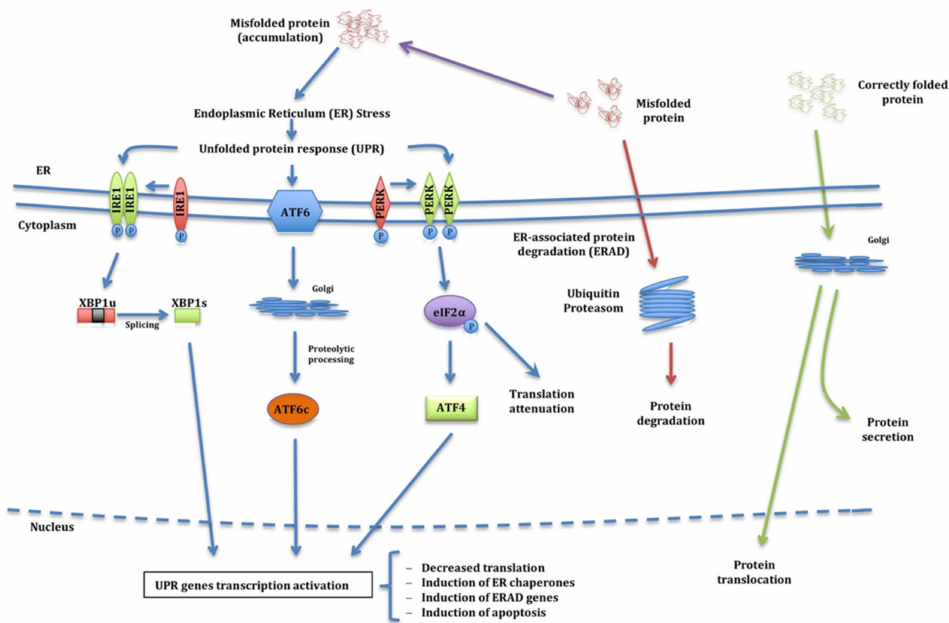
Figure 2. Signalling pathways of the Unfolded Protein Response (UPR). In a normal situation inside the endoplasmic reticulum, proteins are folded and taken to the places where they carry out their function (green arrows). When proteins are not folded correctly, they are stored in the lumen of the endoplasmic reticulum (ER), and the ER-associated protein degradation machinery (ERAD) is activated (red arrows). Occasionally, the ER shows dysfunctions that cause malformed proteins not to be degraded by ERAD and the proteins associate with each other creating aggregates, producing what is known as ER stress (blue arrows). When this occurs, the cell activates the UPR, which might mean that accumulated misfolded proteins can be detected by inositol-requiring enzyme 1 (IRE1), which activates transcription factor 6 (ATF6) and protein kinase R-like endoplasmic reticulum kinase (PERK)